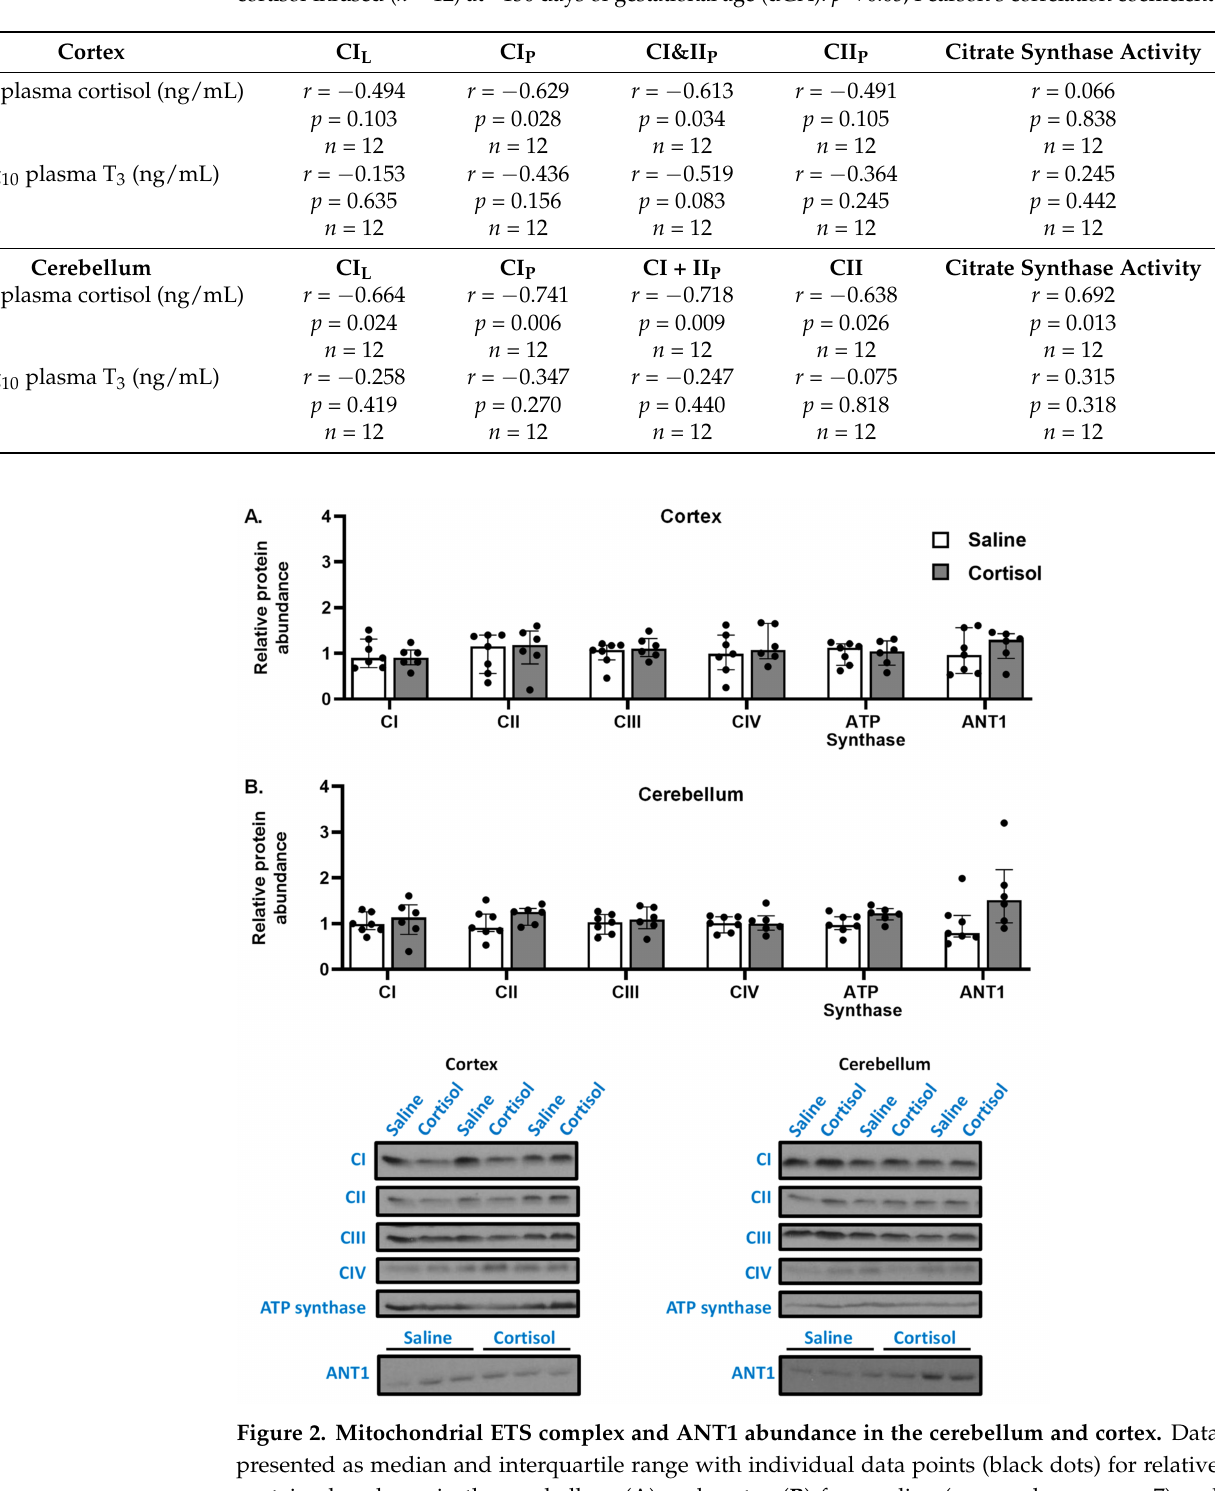
Table 2. Correlations of cortex and cerebellum mitochondrial respiration rates and citrate syn- thase activity with circulating plasma cortisol and T 3 . Relationships between log10 plasma cortisol and T 3 data and Complex I (CI)-linked leak respiration (CI L ), CI (CI P ), CI&II (CI&CII P ) and CII (CII P )- linked OXPHOS capacity and citrate synthase (CS) activity. Data presented for all fetuses, saline and cortisol-infused ( n = 12) at ~130 days of gestational age (dGA). p < 0.05, Pearson’s correlation coefficient.